Question: What does this figure show? Answer in one sentence.
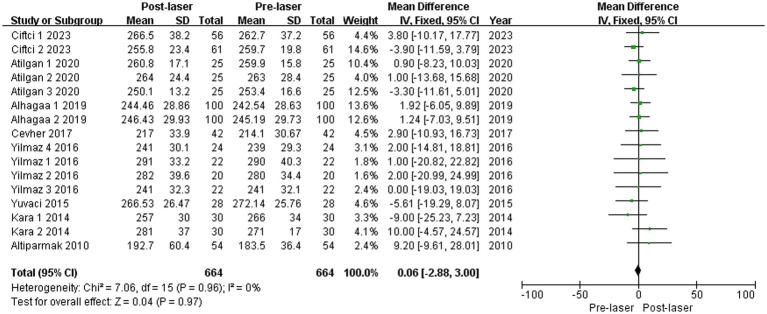
Answer: Forest plot of central macular thickness changes from baseline to postoperative day 1.